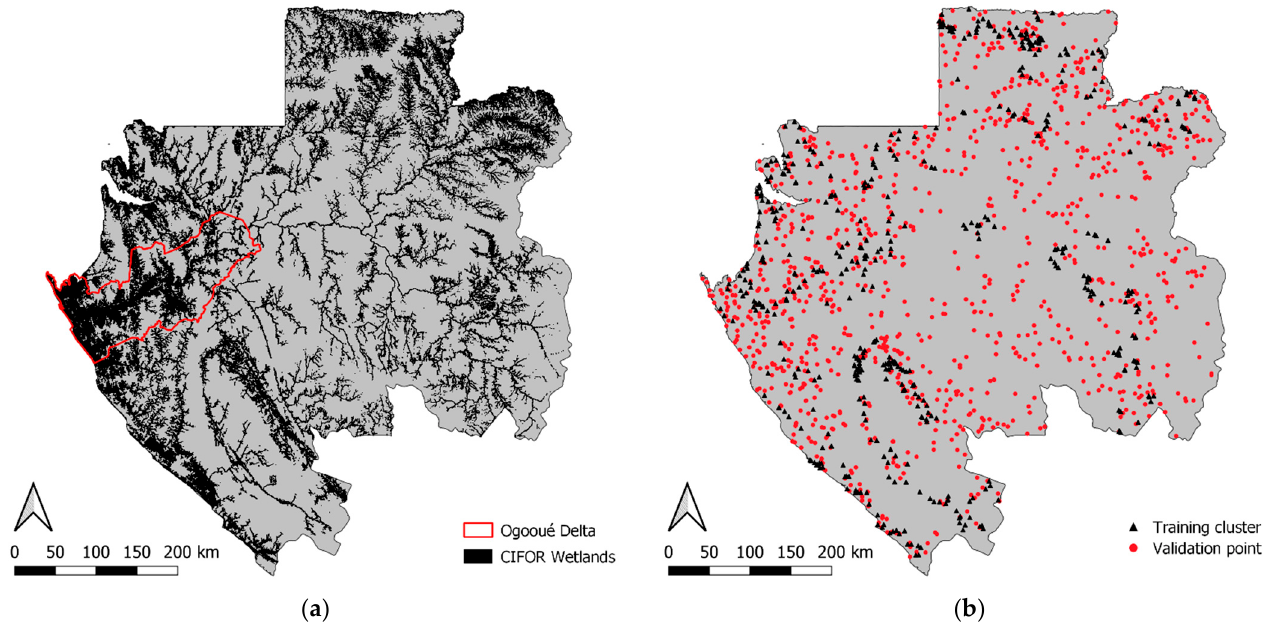
Figure 2. Wetland distribution in Gabon (CIFOR wetlands) ( a ) and the spatial distribution of training clusters (500 clusters in total with 9 points for each cluster) and validation points (1100 points in total) ( b ).